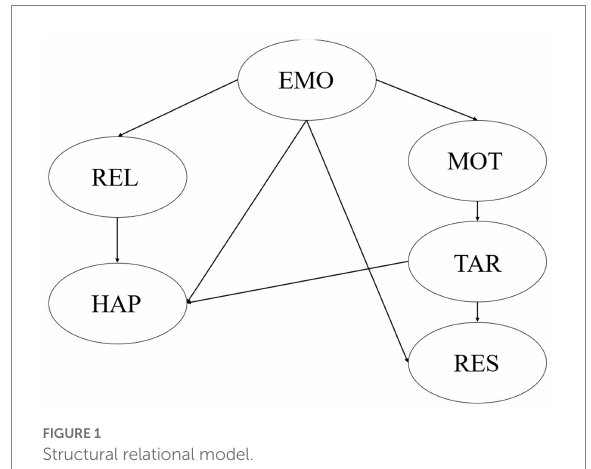
FIGURE 1 Structural relational model.